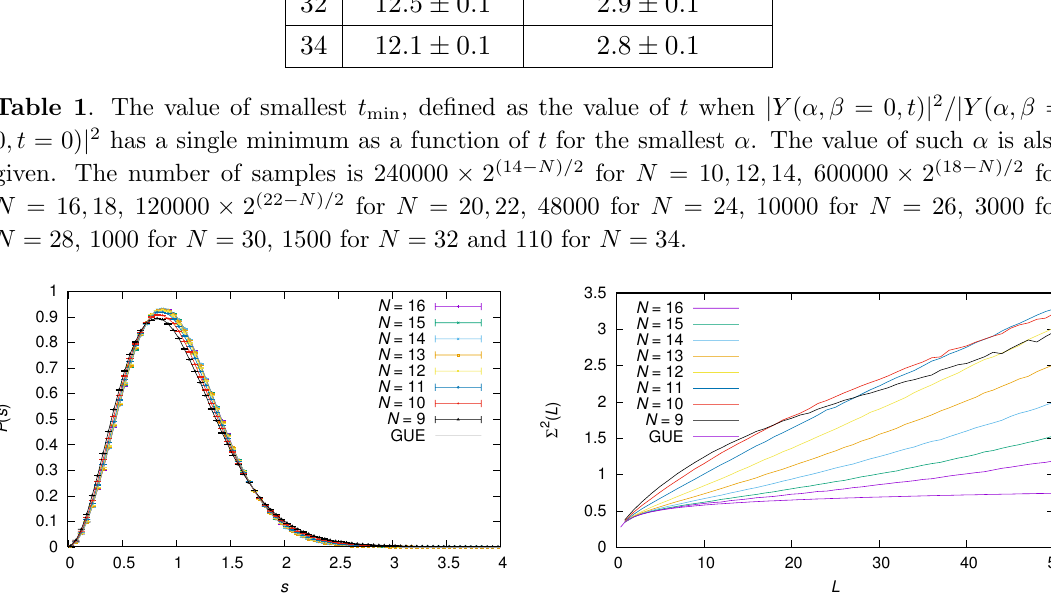
Figure 25 . Unfolded level separation distribution P ( s ) for the RCQ model for N = 9 ; 10 ; : : : ; 16 compared against the Pad(cid:19)e approximant for GUE, and the number variance (cid:6) 2 ( K ). L on the right panel corresponds to K in the